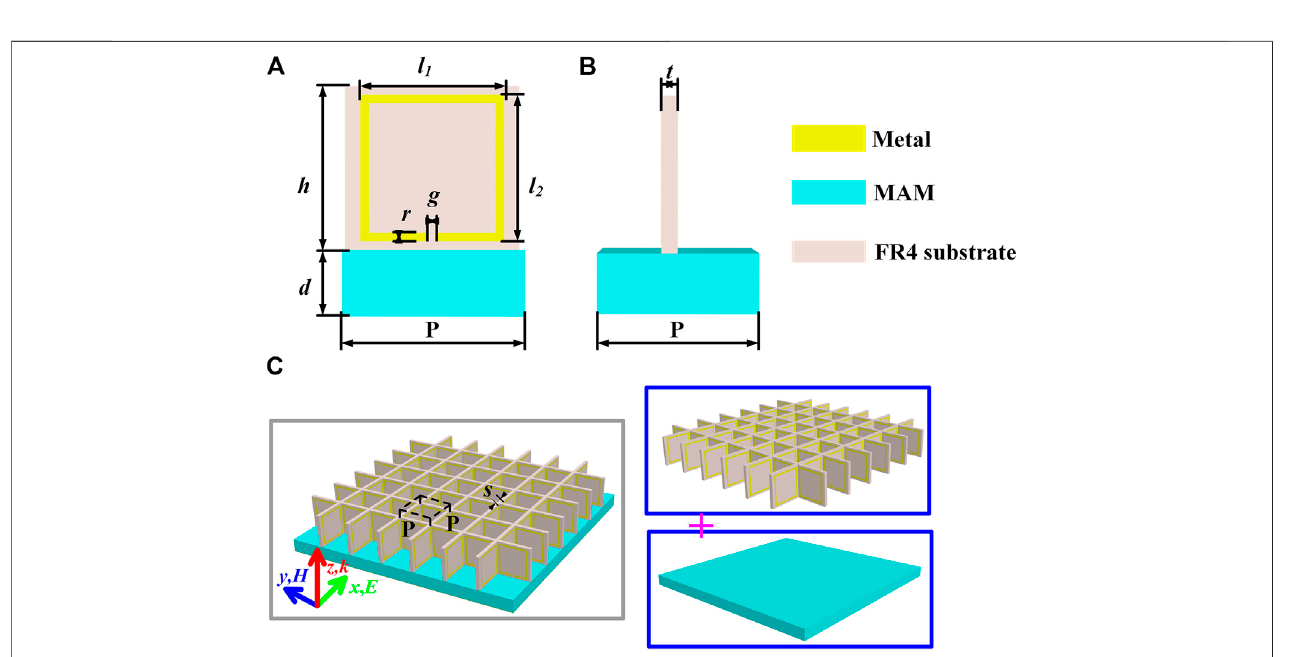
FIGURE 2 | Schematic illustration of the unit of proposed MA: (A) front view, and (B) side view. (C) Perspective view of the MA.